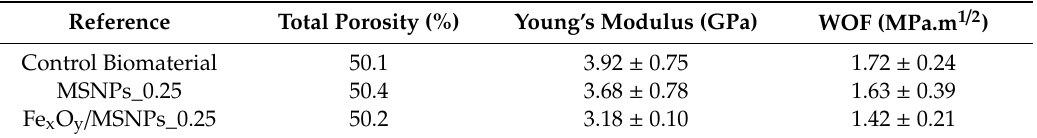
Figure 4. Visualization of the produced MSNPs-loaded scaffolds: ( a ) stereoscopic microscope images of the materials; ( b ) SEM micrographs of the scaffolds (upper images—magn. 100×, lower images—magn. 10000× for control and 5000× for NPs-loaded biomaterials). Table 2. Total porosity as measured by Mercury Intrusion Porosimetry together with the elastic modulus and the work of fracture (WOF) of the different materials obtained from the compression tests.